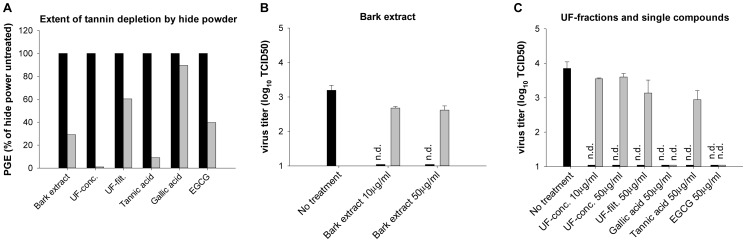
Determination of the active antiviral principle in Hamamelis bark extract.(A) Extent of tannin depletion by precipitation with hide powder. Tannins were depleted from drug solutions by stirring with hide powder for 1 h at room temperature followed by filtration. Phenolics, the main constituting moieties of tannins, were photometrically quantified before (black bars) and after (grey bars) hide powder treatment by Folin-Ciocalteu’s phenol reagent using a pyrogallol standard curve. Pyrogallol equivalents (PGE) of hide powder treated samples were normalized to PGE of untreated samples, set to 100%. (B–C) Antiviral effect of tannins. A549 cells were infected in triplicates with pandemic H1N1 A/Lux/46/2009 (MOI 0.05) and were left untreated or treated for 24 h with bark extract (B), UF-fractions or isolated (pseudo)tannins (C) which had been (grey bars) or had not been (black bars) treated with hide powder. Titers were determined at 24 h post infection by TCID50. n.d., not detectable or TCID50<1.